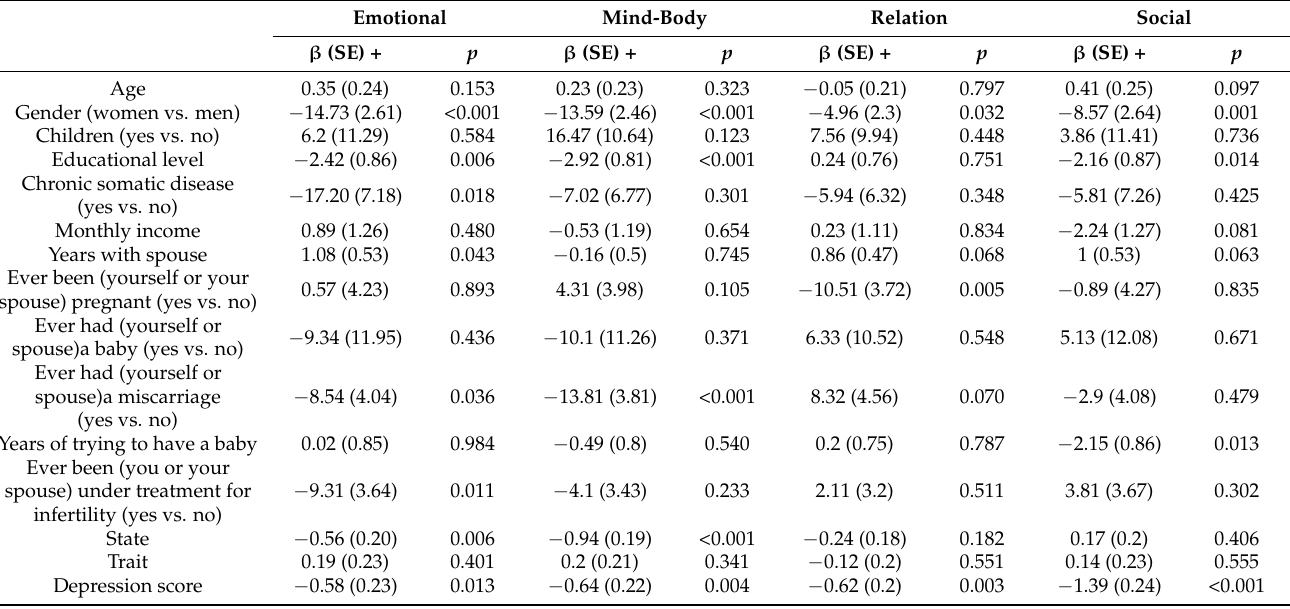
lower scores in the “Treatment” subscale, indicating worse quality in that specific sector, were had by women, participants with higher levels of education, and those with greater state scores. Table 3. Multiple linear regression results for “Emotional”, “Mind-body”, “Relation”, and “So- cial” subscales. Emotional Mind-Body Relation